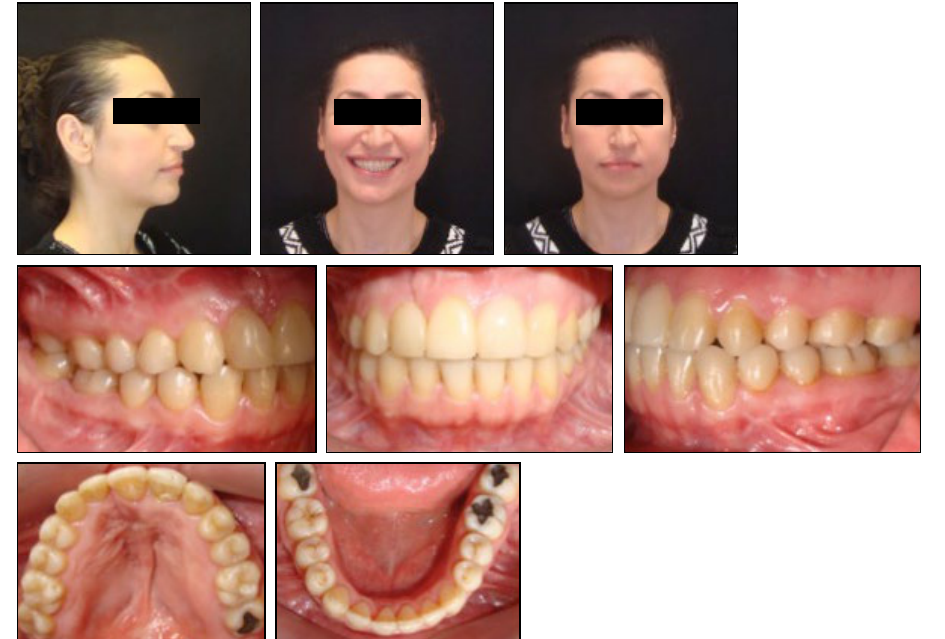
Figure 5. Facial and intraoral photographs after restorative treatments.